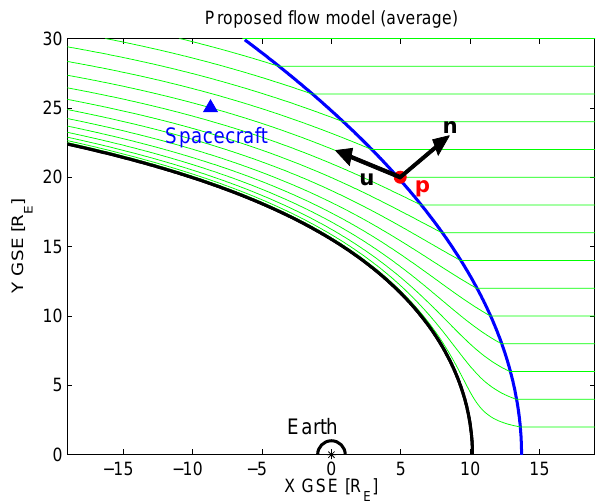
Fig. 3. A schematic representation of back-tracing of the flowline to the bow shock and of the relevant shock parameters used in Sect.